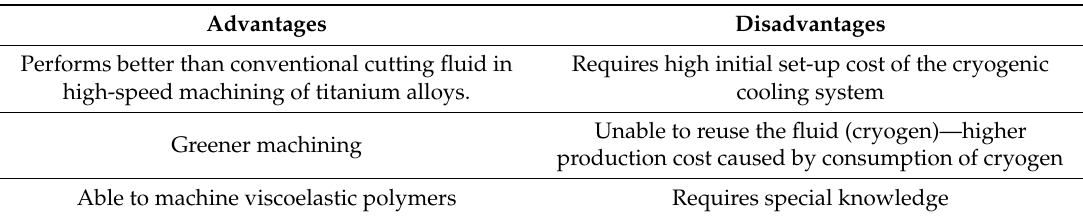
Table 1. Advantages and disadvantages of cryogenic turning. Advantages Disadvantages Performs better than conventional cutting fluid in high-speed machining of titanium